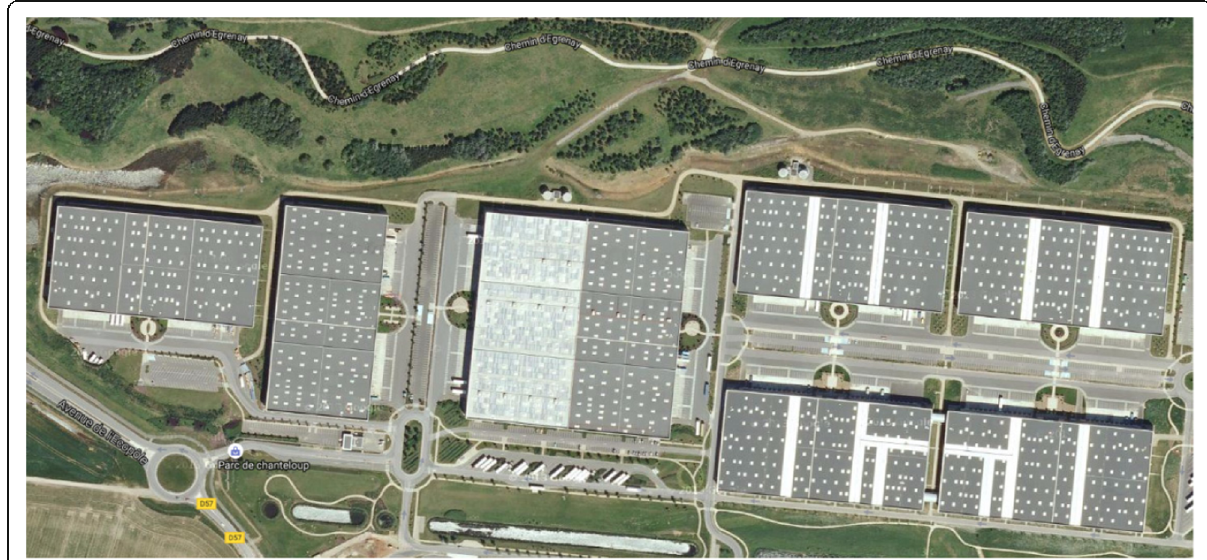
Fig. 6 Prologis freight village “ Chanteloup ” in Moissy-Cramayel,